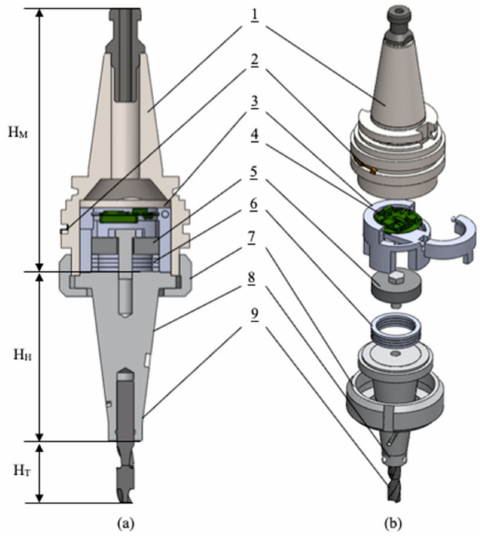
Figure 13. ( a )—Energy harvester device assembly section view, ( b )—Energy harvester device assem- bly exploded